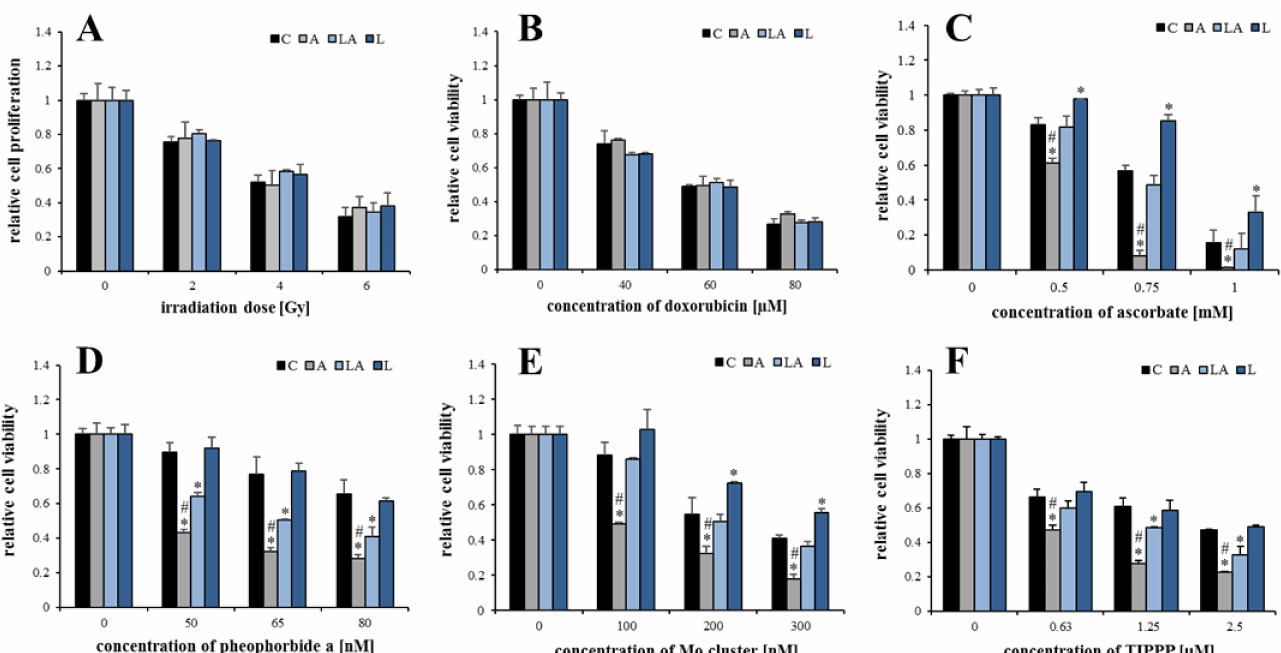
Figure 3. The effect of lactic acidosis on cancer cell sensitivity to radio-, chemo-, and phototherapy. PaTu-8902 cells were cultured in experimental media for 72 h and then treated with ( A ) X-ray irradiation, ( B ) doxorubicin, ( C ) phar- macological ascorbate, and ( D – F ) photodynamic therapy using pheophorbide a , Mo cluster, and 5,10,15,20-tetrakis(4- isopropylphosphinatophenyl)porphyrin (TIPPP), respectively. The proliferation of irradiated cells after reseeding and subsequent 72 h incubation and viability of the rest after 24 h were measured by resazurin assay. C, control; A, acidosis; LA, lactic acidosis; L, high lactate (* p < 0.05 compared to C, # p < 0.05 when comparing A and